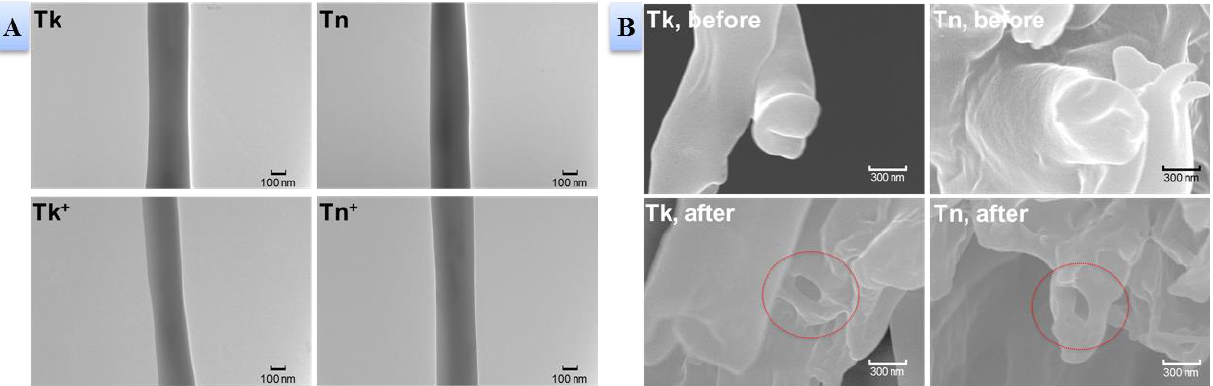
Figure 2. ( A ) The transmission electron microcopy (TEM) images of Tk, Tn, Tk + , and Tn + CSNFMs after immersion in PBS for two weeks (bar = 100 nm). ( B ) The field-emission scanning electron microscopy (FE-SEM) images of Tk and Tn core-sheath nanofiber membranes (CSNFMs) before and after immersion in PBS for two weeks (bar = 300 nm). The red circles indicate the hollow core structure after eluting HA from the core.